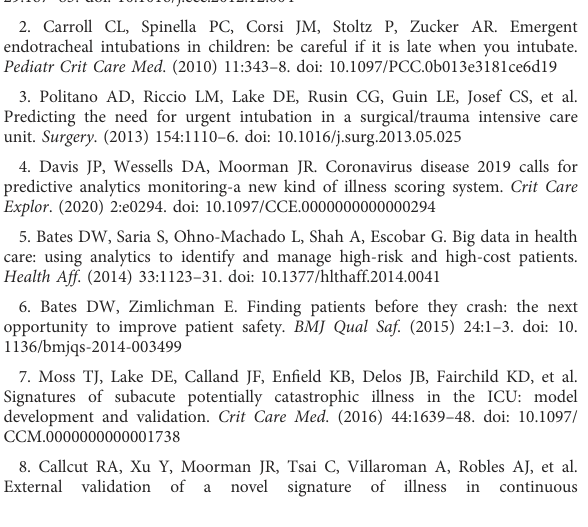
SUPPLEMENTARY FIGURE A1 Histogram of time between ventilator respiratory rate entries in the electronic medical record on a logarithmic scale. Most entries are within 12 hours of the preceding entry. SUPPLEMENTARY FIGURE A2 Empirical relative risk for cardiac surgery (left), medical (center), and non- cardiac surgery (right) patients as a function of age and each feature. On each panel, younger patients are to the left, and lower values of the feature are to the bottom. Each colored tile estimates the relative risk of unplanned intubation for each decile of age and the feature based on the surrounding quintile. Deciles remain the same across patient type panels. Higher relative risk is redder while lower is bluer. SUPPLEMENTARY FIGURE A3 Marginal risk pro fi les for each feature in the random forest model. Note that marginal risk pro fi les average out any interdependence between features, such as the dependence of heart rate on age. The (natural) log odds of unplanned intubation in the next 12 hours (ordinate) is shown as a function of the value of each measured variable (abscissa) holding all other features at their median